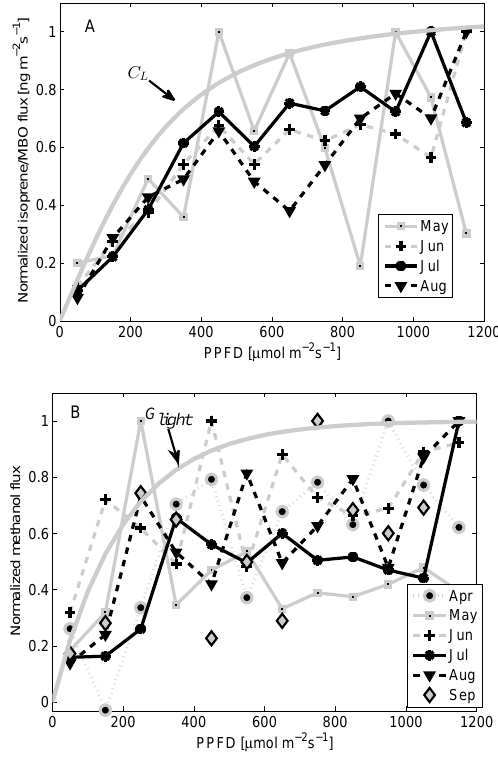
Figure 3. Temperature normalized isoprene+MBO (a) and methanol (b) fluxes (bin-medians) as a function of PPFD (May– August and April–September, respectively; years 2010–2013). The isoprene fluxes were normalized by multiplying the measured val- ues by a factor of C − 1 (Eq. 7) whereas the methanol fluxes were T multiplied by a factor of (cid:48) − 1 (Eq. 11). In addition, values for each month were scaled to the range of [ 0 − 1 ] . Those periods when rela- tive humidity was larger than 75% were rejected from the methanol analysis to avoid